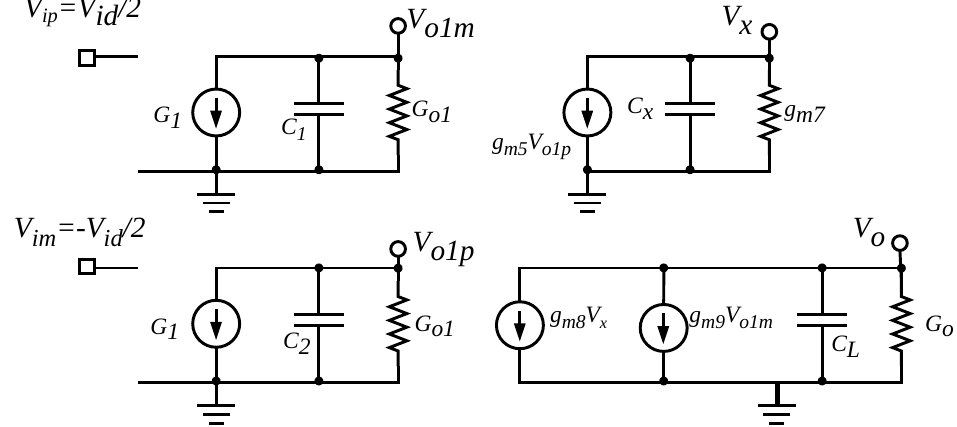
Figure 4. Simplified small-signal equivalent circuit of the amplifier after applying Miller approxima- tion for frequency response